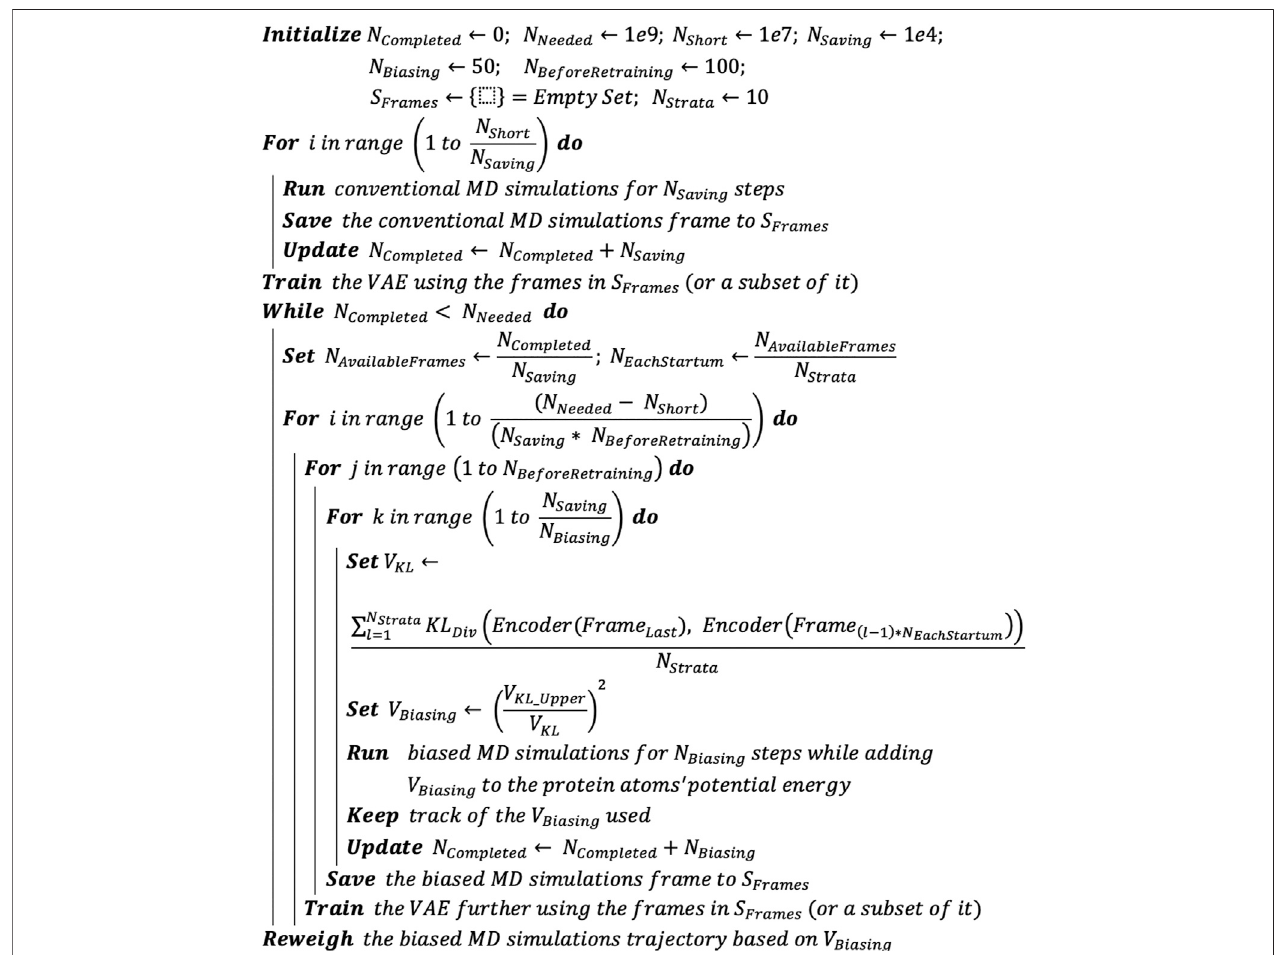
FIGURE 3 | DESP algorithm. The DESP combines DNNs with MD simulations to achieve enhanced sampling of molecules ’ conformation spaces.